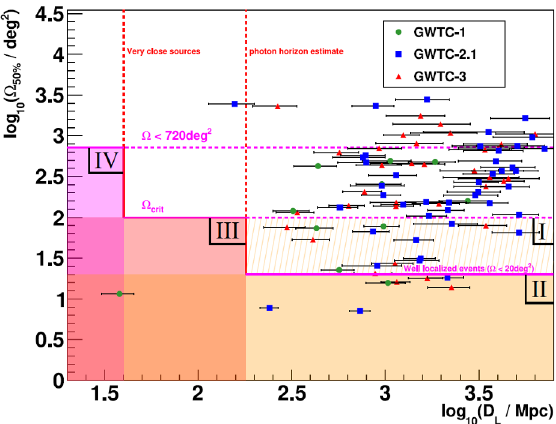
Figure 3. All GW events from GWTC-1 (green dots), GWTC- 2.1 (blue squares) and GWTC-3 (red triangles) in the space of source distance DL and localization ⌦ 50% . Events which are not within the field of view in the 1 day time window are drawn with empty markers, while events which do at least partially overlap have solid markers. Three red crosses mark the events which pass the selection criteria for the short time window and also have an overlap with the field of fiew during that time. The shaded re- gions define the set of accepted events according to the selection citeria described in the text. The hatched region marks class I which is solely relevant for the short analysis time window and the solid regions mark classes II, III and IV